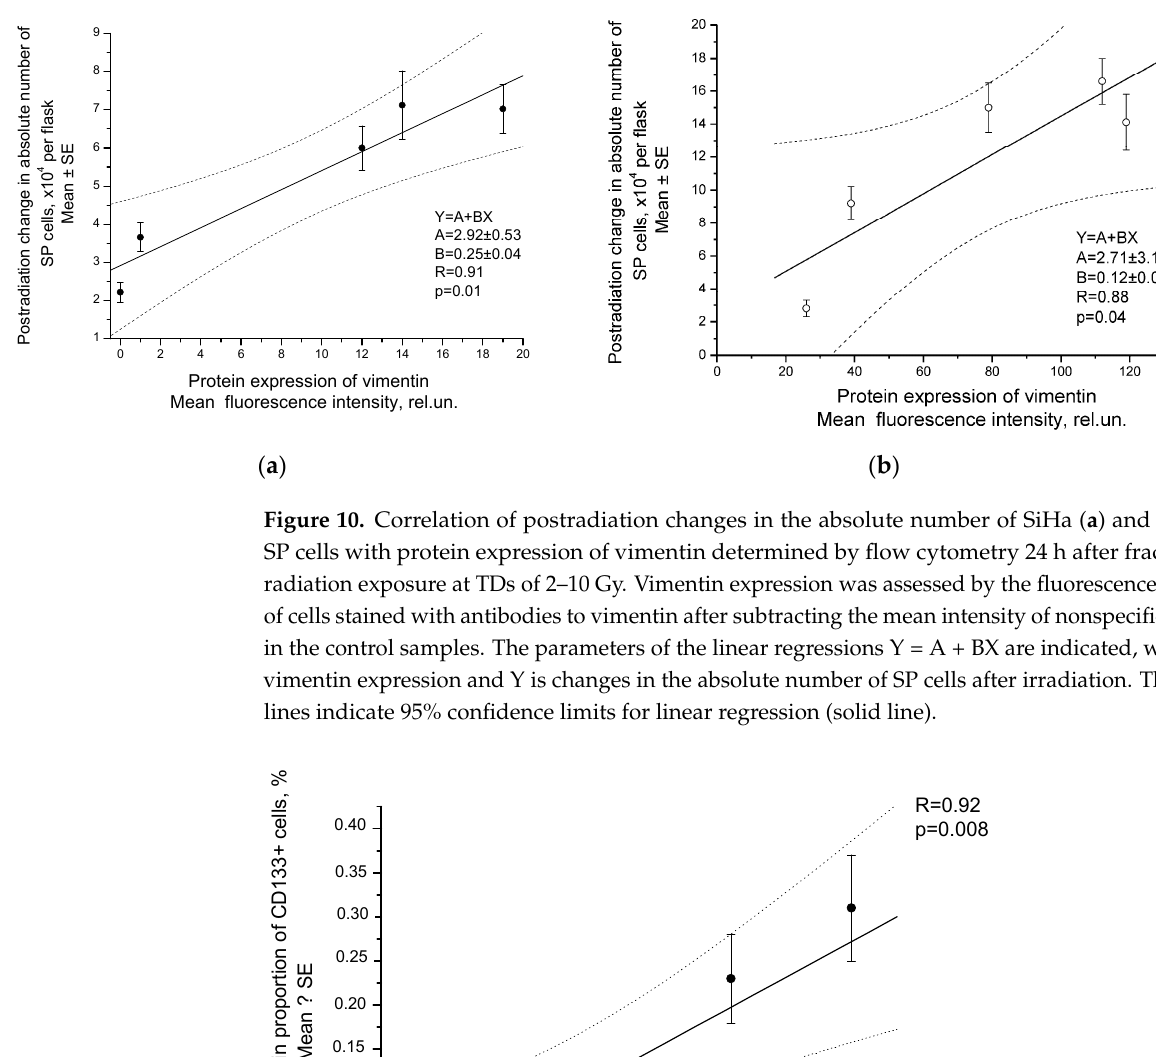
Y=A+BX A=2.92±0.53